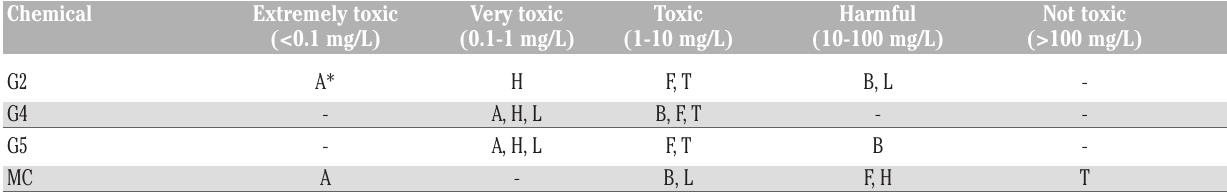
Table 2. Toxicity classification of dendrimers (G2, G4, G5) and minocycline (MC) based on European Union Commission Guideline 93/67/EEC 13 and the most sensitive bioassay measurement endpoint values (LCx/ECx/ICx, etc.).